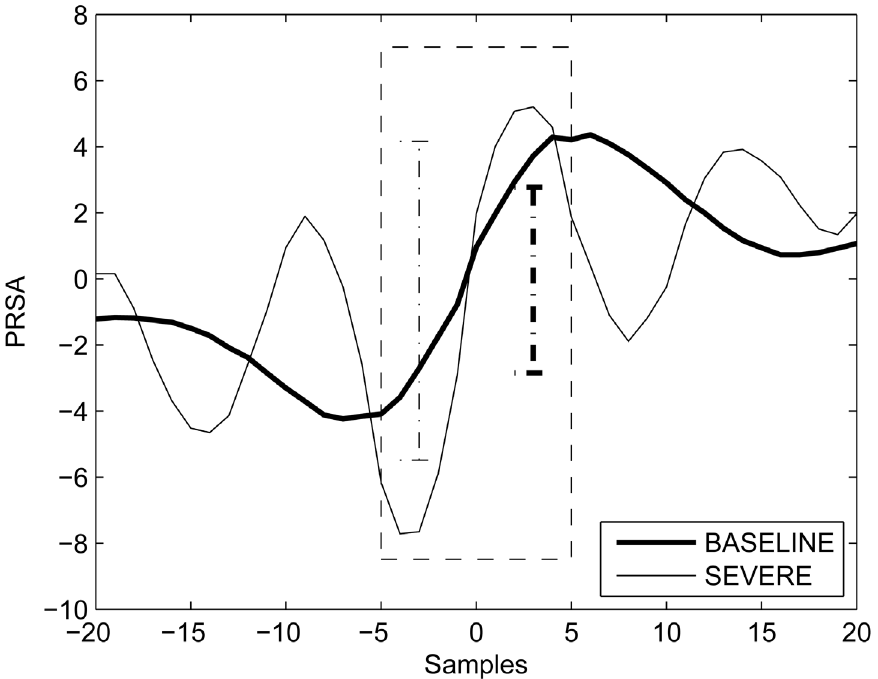
Figure 3. PRSA curve (DC) for a single case during BASELINE (bold line) and SEVERE UCO (PRSA’s mean value was removed). The analysis was performed on stable (concatenated baseline free of FHR decelerations segments) fRR intervals. The dashed box emphasizes samples used for computing DC ( T =5). Vertical dotted bars depict DC in the two cases considered. doi:10.1371/journal.pone.0104193.g003 PLOS ONE |